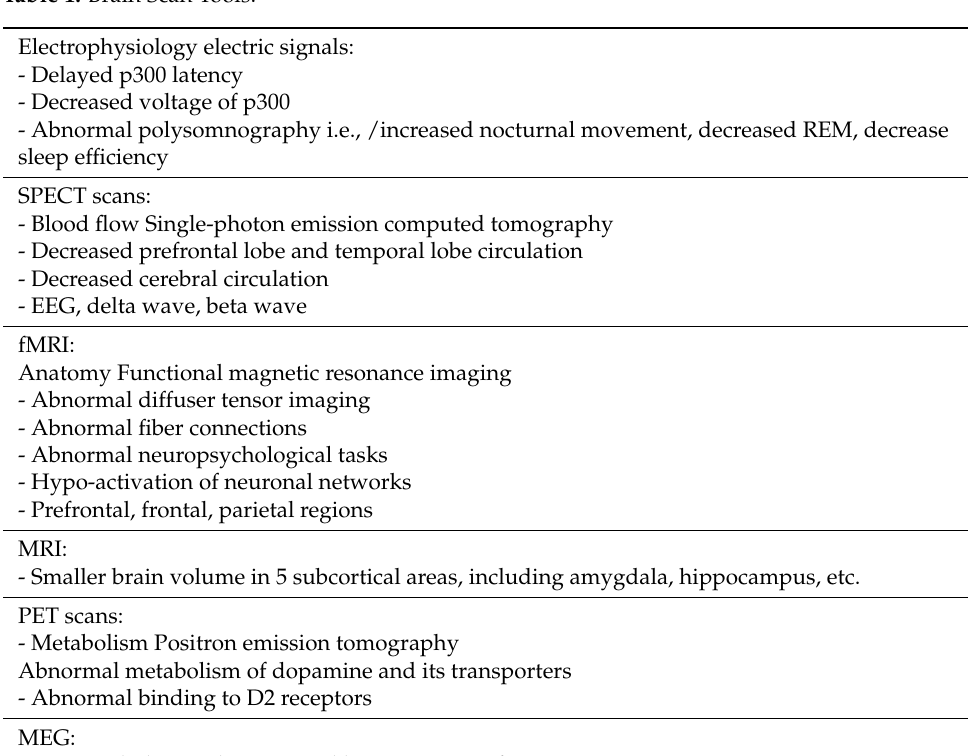
Table 1. Brain Scan